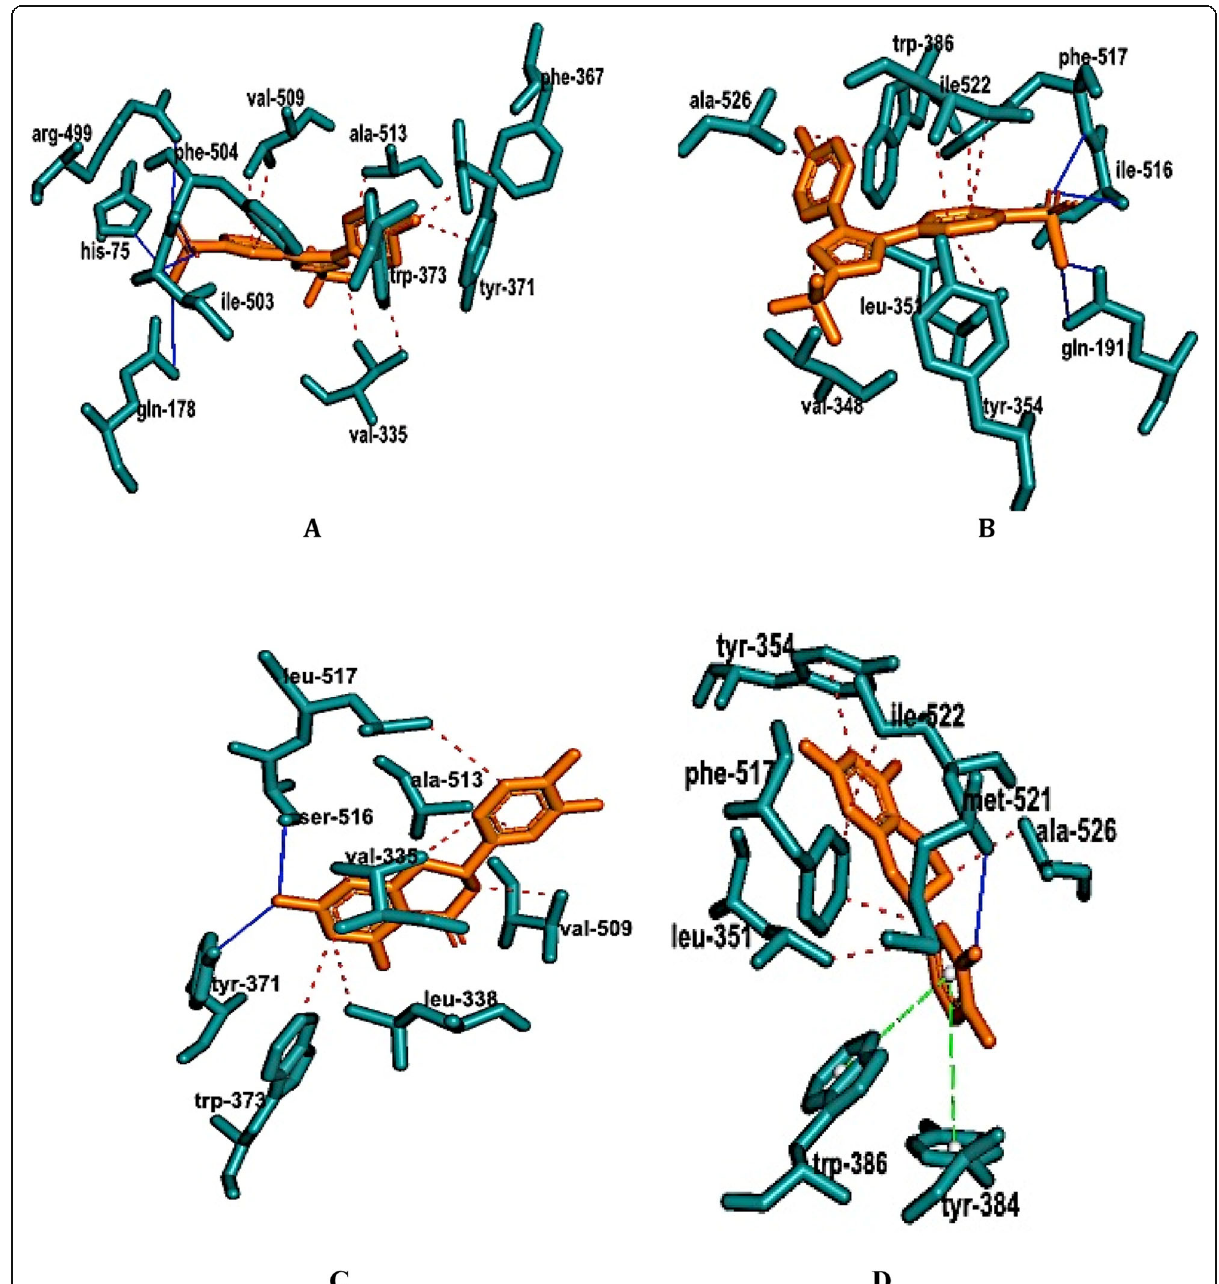
Fig. 3 a Interactions of celecoxib (orange) with key residues at the catalytic site of COX-2, the dotted red lines represent the hydrophobic interactions while the blue lines represent hydrogen bonds interactions. b Interactions of celecoxib (orange) with key residues at the catalytic site of COX-1; the dotted red lines represent hydrophobic interactions while the blue lines represent hydrogen bonds interactions. c Interactions of eriodicytol (orange) with key residues at the catalytic site of COX-2; the dotted red lines represent hydrophobic interactions while the blue lines represent hydrogen bonds interactions. d Interactions of eriodicytol (orange) with key residues at the catalytic site of COX-1; the dotted red lines represent hydrophobic interactions, the blue lines represent hydrogen bonds interactions and the dotted green lines represent